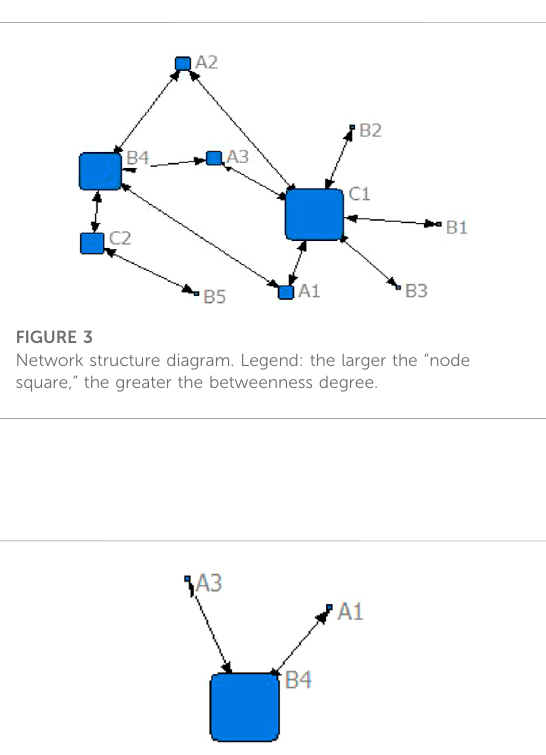
FIGURE 4 Network after removing the key resource nodes.